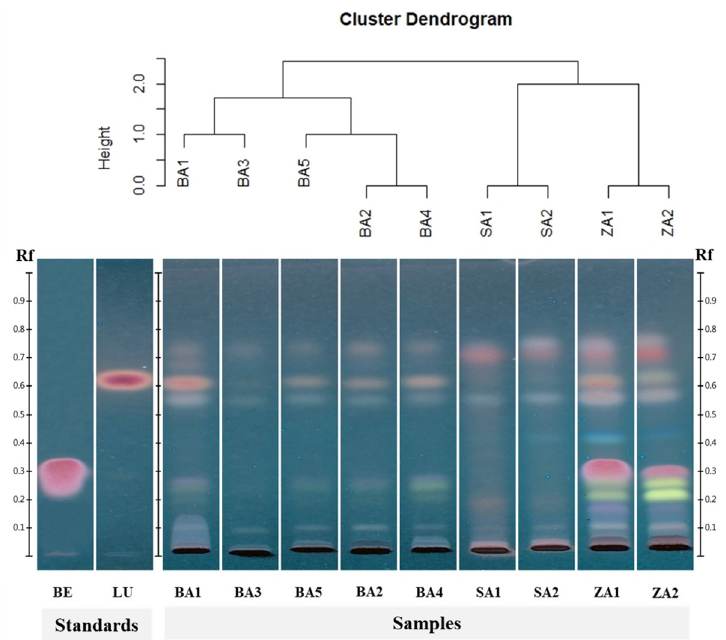
Fig 4. Cluster dendrogram from hierarchical cluster analysis (HCA) and TLC chromatograms under UV light at 366 nm after derivatization with anisaldehyde-sulfuric acid showing the presence of betulinic acid (BE), lupeol (LU), BA1-BA5, SA1-SA2, and ZA1-ZA2.